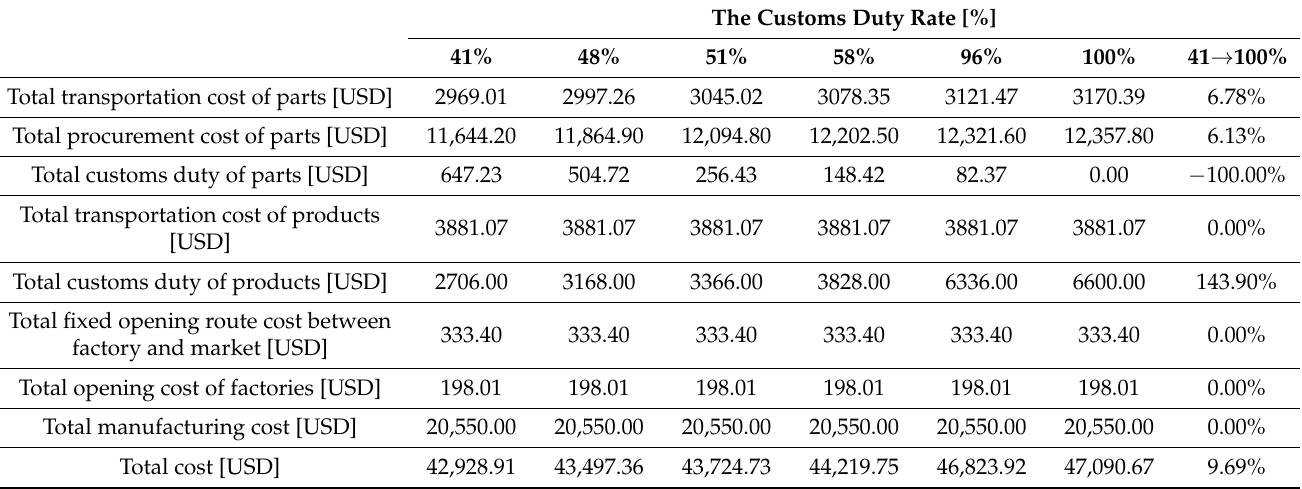
Table 7. Sensitivity analysis of costs to changes in customs duty rate from 41% to 100% in scenario B1.